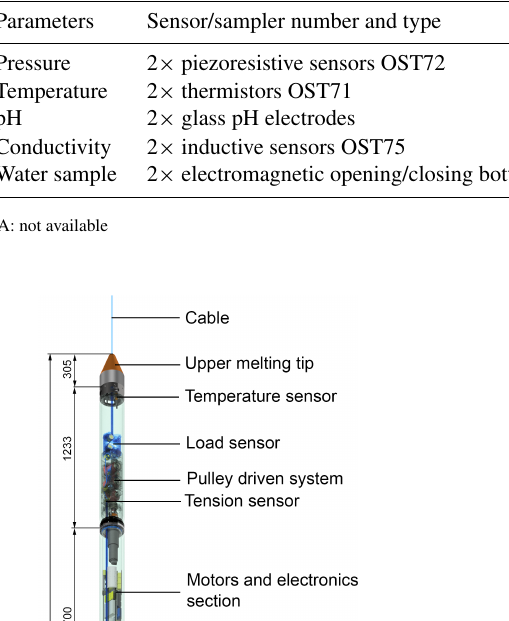
Table 1. Main parameters of RECAS onboard sensors and sampler.